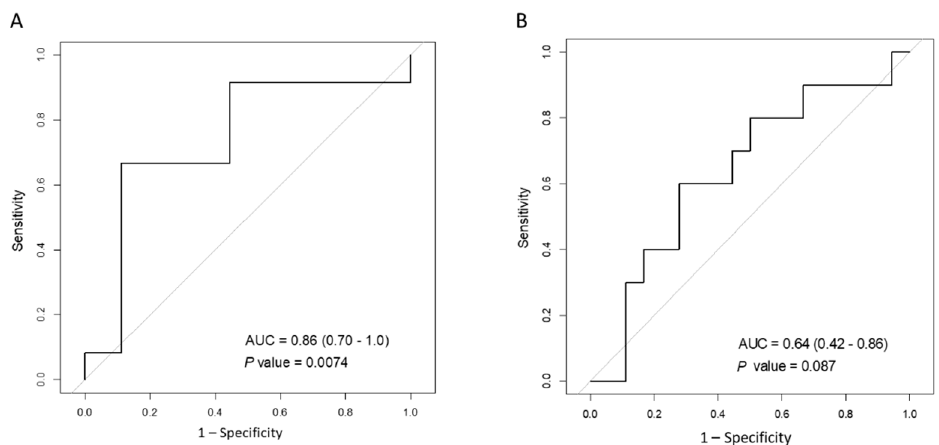
Figure 1. ROC curve for predicting improvement of more than minimal clinically important difference of ( A ) SGRQ total score (4 points) and ( B ) 6MWD (24 m) by duration from diagnosis of FILD to start of PR. ROC, receiver operating characteristic; AUC, area under curve; SGRQ, St. George’s Respiratory Questionnaire; 6MWD, 6-min walk distance; FILD, fibrosing interstitial lung disease; PR, pulmonary rehabilitation.